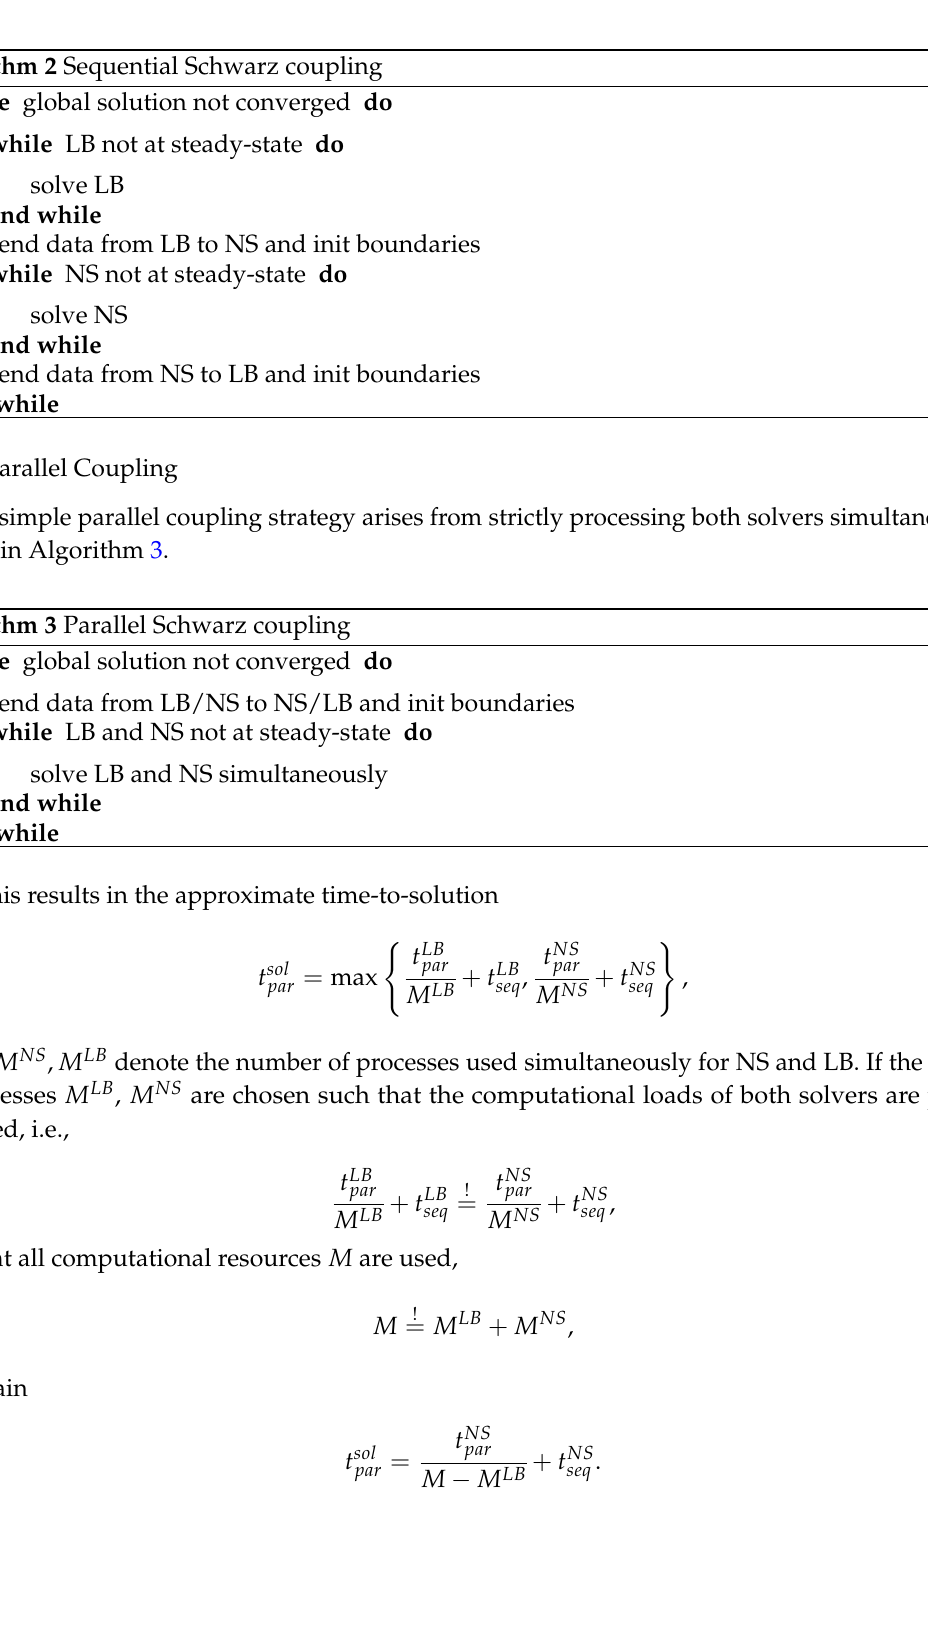
Algorithm 2 Sequential Schwarz coupling